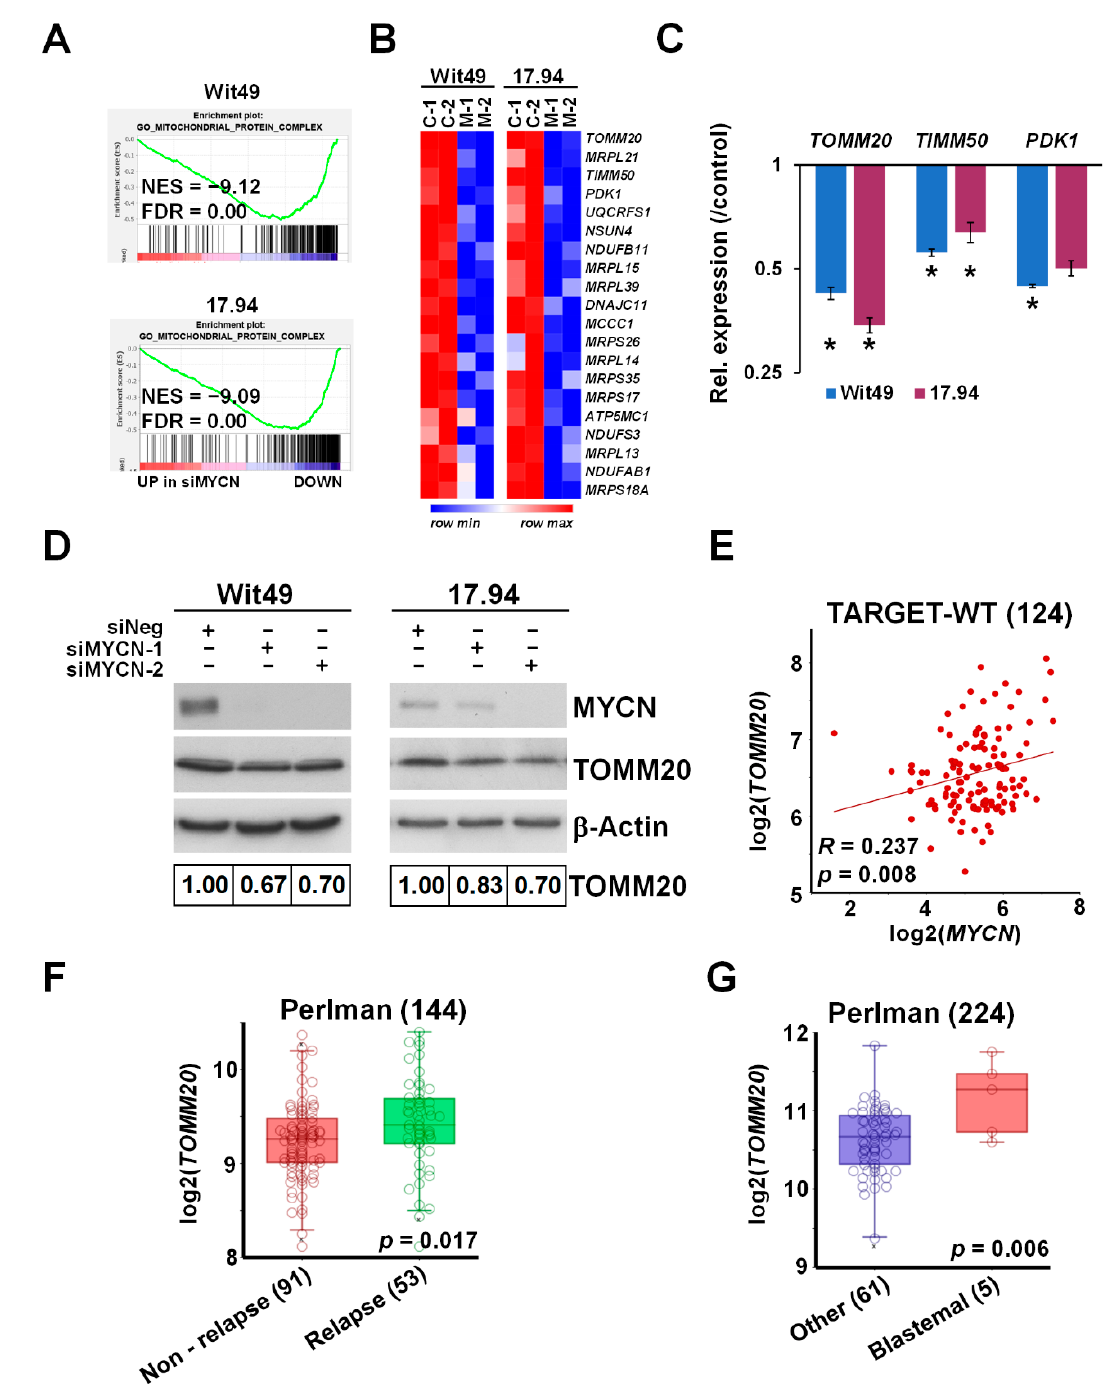
Figure 5. MYCN regulates TOMM20 and other mitochondrial function genes. ( A ) GSEA showing downregulation of genes encoding for mitochondrial protein complexes with MYCN depletion. ( B ) Heatmap displaying the expression of the top 20 genes in the leading edge of the Gene Ontology (GO) mitochondrial protein complex gene category in MYCN-depleted WT cells. ( C ) Validation of select mitochondrial genes in Wit49 and 17.94 cells by qPCR, 48 h after MYCN knockdown. A representative of three biological replicates is shown. t -tests were performed on the biological replicates (* p < 0.05). ( D ) Western blot and quantification showing the reduction of TOMM20 protein expression after 72 h of MYCN depletion. ( n = 3). ( E ) Expression of MYCN and TOMM20 genes was significantly correlated in the TARGET-WT dataset (SRP012006). ( F ) Relapsed WTs had significantly higher expression of TOMM20 mRNA than non-relapsed ones, as detected in GSE10320. ( G ) TOMM20 was also more highly expressed in blastemal WTs than in tumours with other histology (GSE31403). Uncropped Western blots are available in Figure S5B.